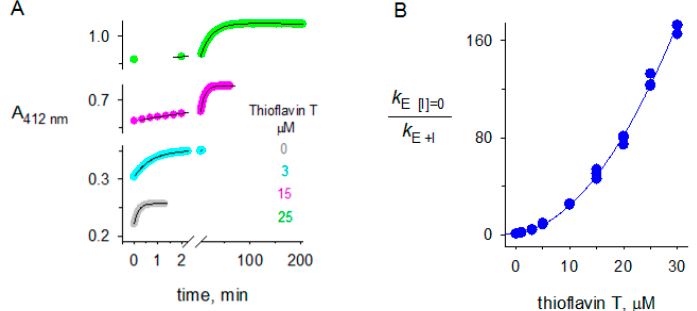
Figure 7. Thioflavin T inhibition of butyrylthiocholine hydrolysis by BChE. ( A ) Examples of experimental traces that were analyzed with Equation (1) to obtain values of k E . The substrate S was butyrylthiocholine ([S] 0 = 5 µM), the inhibitor I was thioflavin T (ThT) ([I] as indicated), and [ E ] tot was 0.68 nM; ( B ) Values of k E + I obtained from traces like those in Panel A were analyzed with Equation (4) assuming constant percent error in the measured k E[I] = 0 / k E + I values to obtain the fitted parameters K I = 1.61 ± 0.11 µM and K II = 5.84 ± 0.16 µM 2 . These values corresponded to a maximum for the affinity in the binary complex relative to that in the ternary complex ( K I12 / K I1 ) of 0.56 ± 0.04.